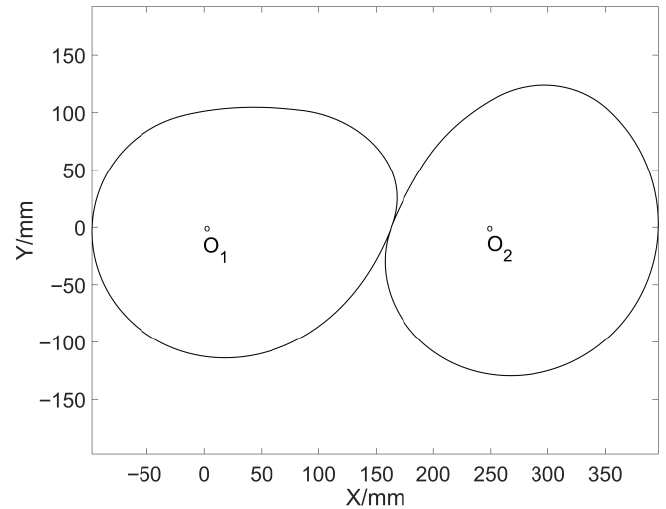
Figure 14. The pitch curves of noncircular gears.